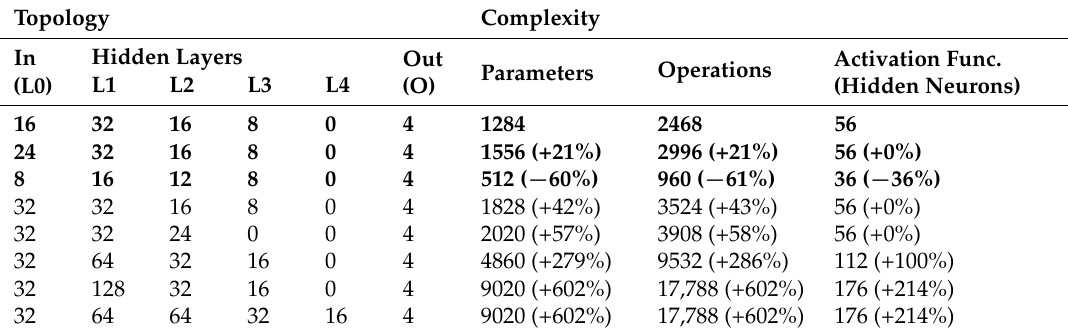
Table 2. This theoretical values of complexity for different neural network topologies.